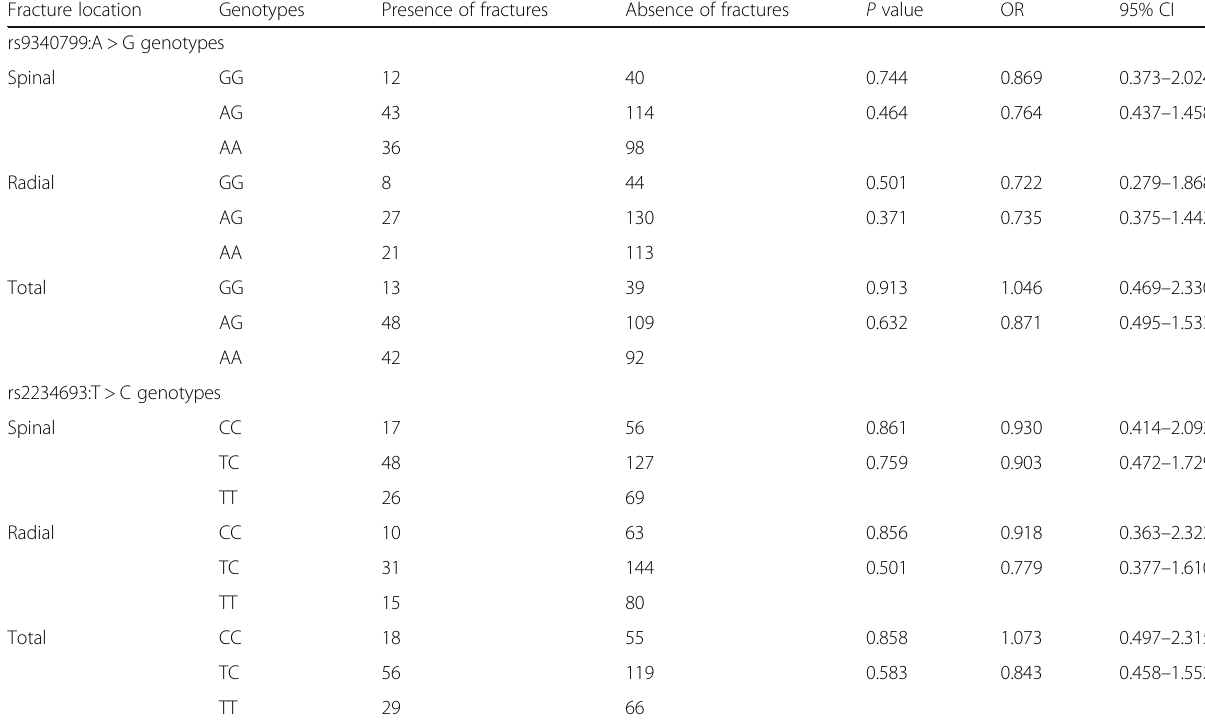
Table 4 The effects of the rs9340799 and rs2234693 genotypes on fracture prevalence